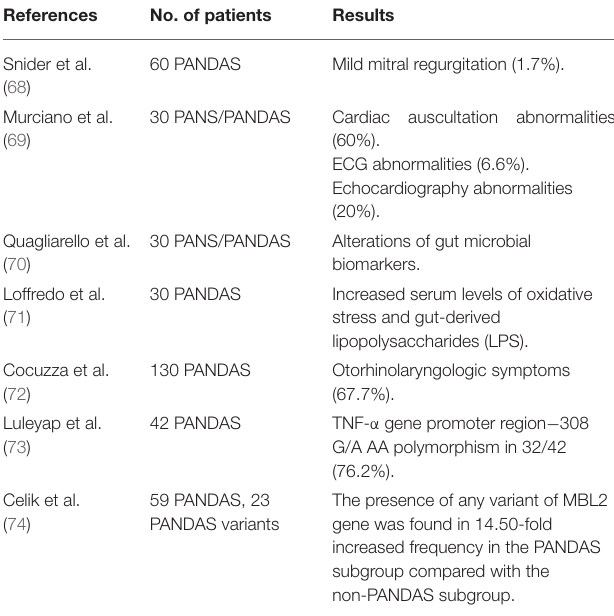
TABLE 5 | Other diagnostic evaluations in patients with PANDAS or